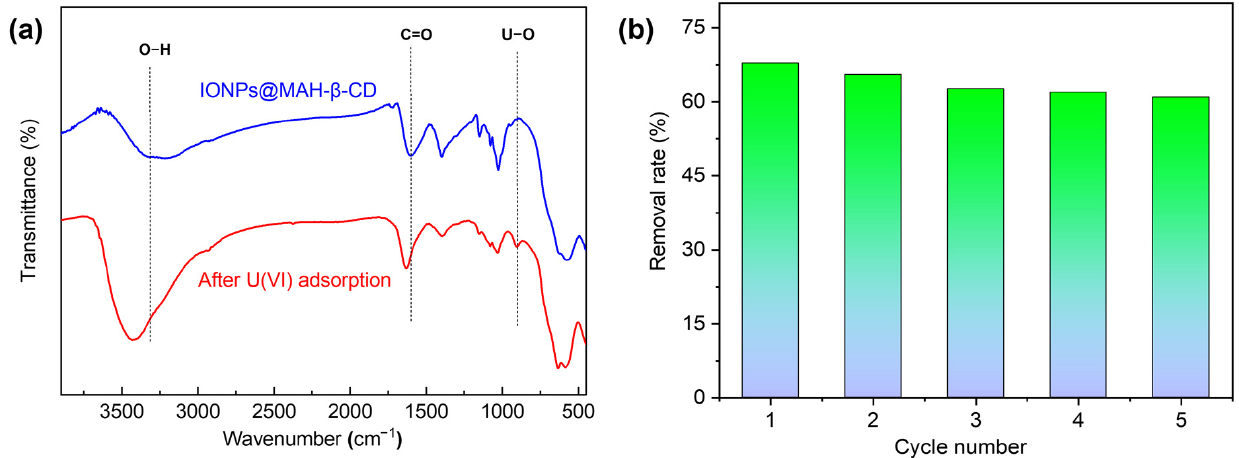
Figure 8. ( a ) The FTIR spectra of IONPs@MAH- β -CD before and after U(VI) adsorption; ( b ) recycla- bility of IONPs@MAH- β -CD.